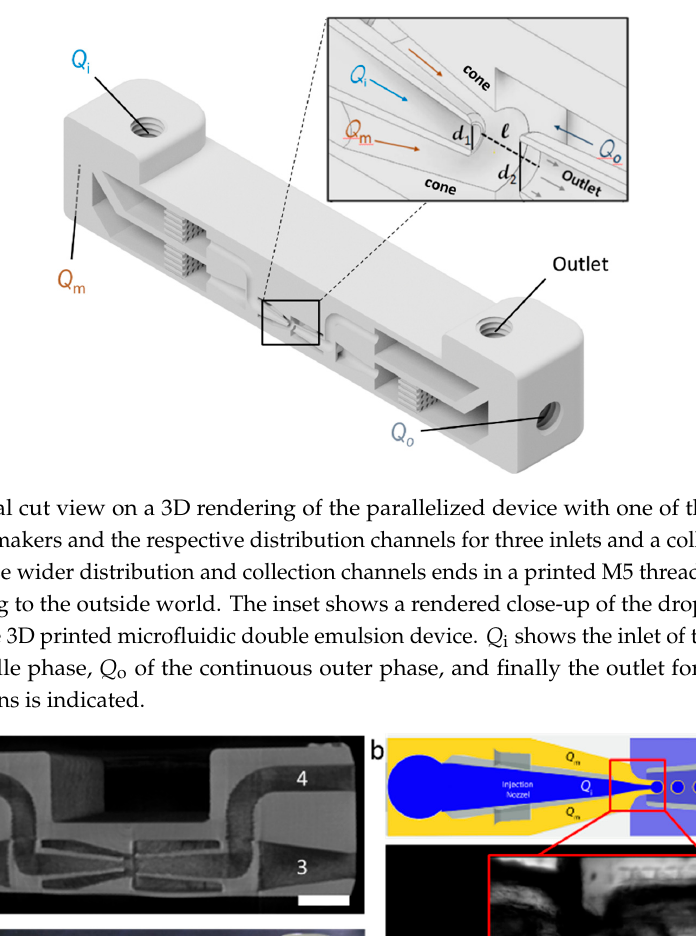
Figure 1. Lateral cut view on a 3D rendering of the parallelized device with one of the four double emulsion drop makers and the respective distribution channels for three inlets and a collection channel. Each one of these wider distribution and collection channels ends in a printed M5 thread to connect the chip with tubing to the outside world. The inset shows a rendered close-up of the droplet generation site inside of the 3D printed microfluidic double emulsion device. Q i shows the inlet of the inner phase, Q m of the middle phase, Q o of the continuous outer phase, and finally the outlet for collecting the double emulsions is indicated.